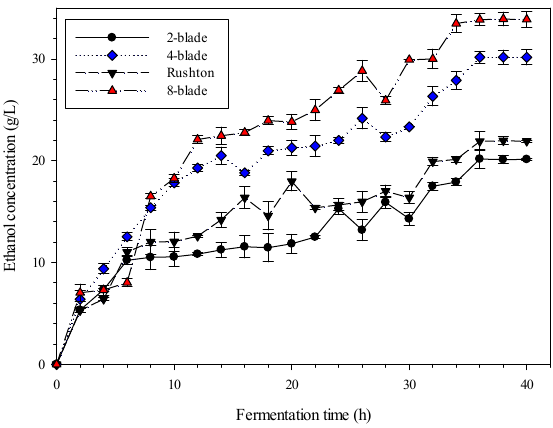
Figure 6. Effect of impeller type on fermentation of treated Napier grass at 30 °C, a pH level of 5, an Figure 6. E ff ect of impeller type on fermentation of treated Napier grass at 30 ◦ C, a pH level of 5, agitation speed of 70 rpm, and 2 wt % yeast . an agitation speed of 70 rpm, and 2 wt %